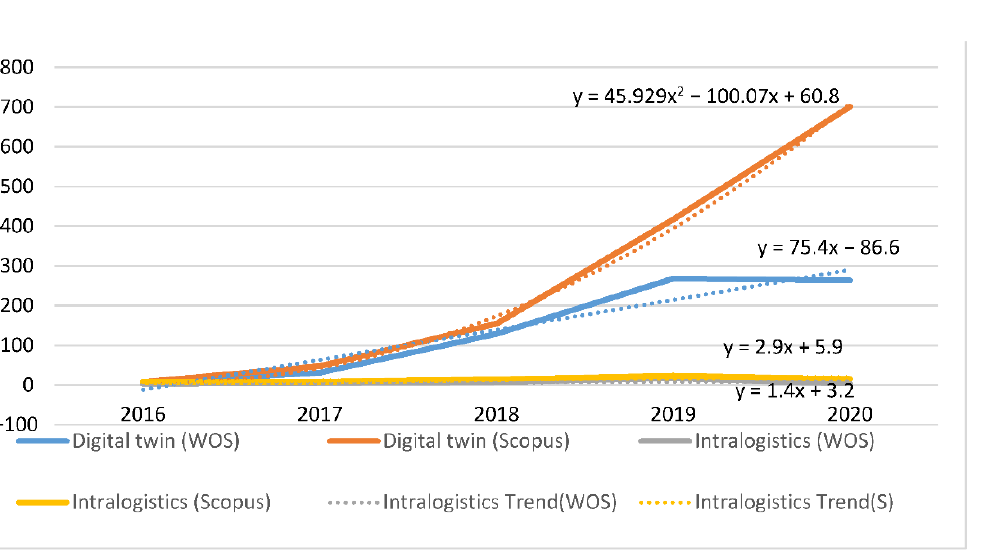
Table 4. Pearson’s coefficient and coefficient of determination for the analyzed population of pub- lications.